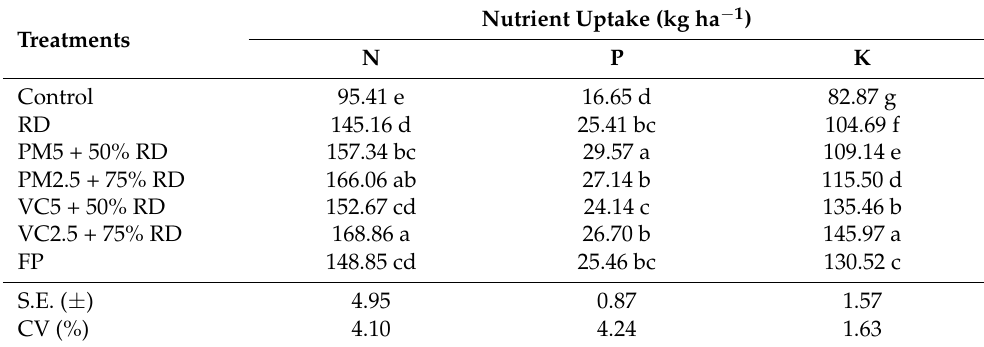
Table 2. The nutrient uptake by rice under different treatments of organic manures and inorganic fertilizers.